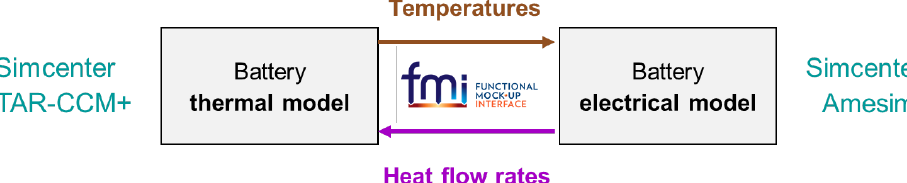
Figure 7. Co-simulation between battery thermal (CFD) and electrical (system simulation) model.